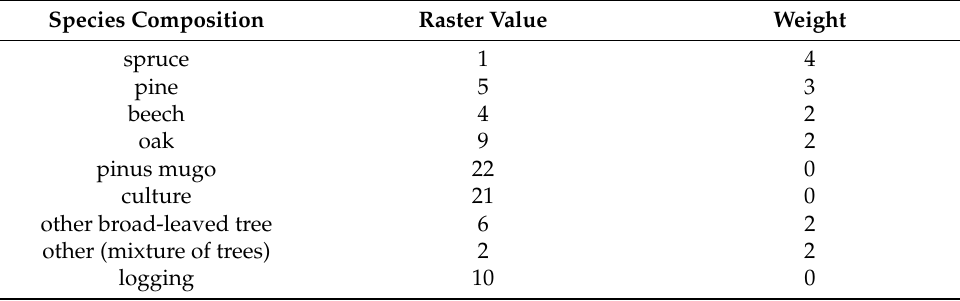
Table 2. Weights assigned to individual species